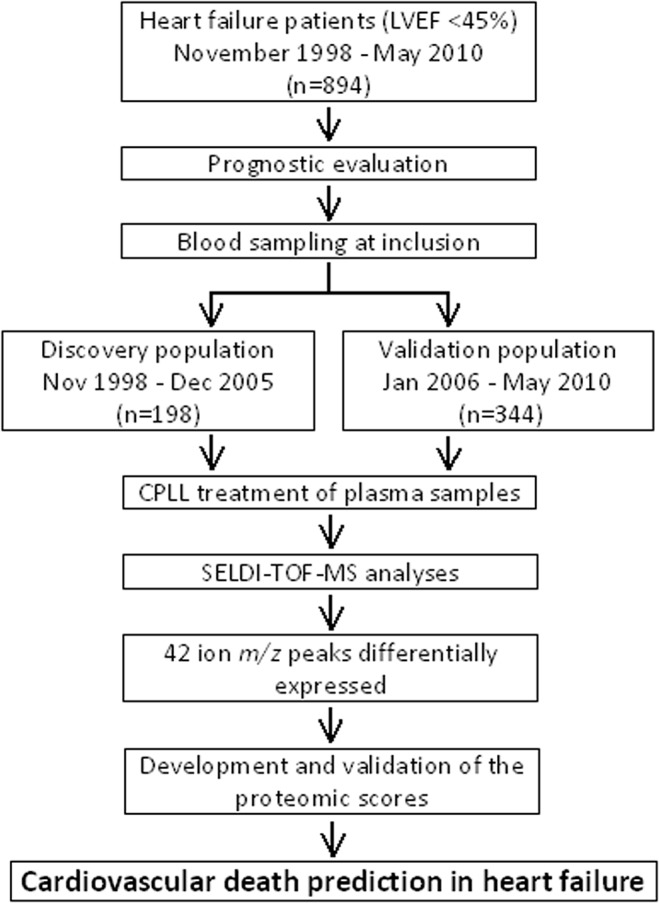
Flow chart of the study.Overview of the study design and analyses performed to build the proteomic scores and to test their validation. A Bonferroni correction was applied on the ion m/z peaks detected by SELDI-TOF analysis. Three different statistical regression methods (SVM, sPLS-DA and LASSO) were used to build the scores with the 42 differentially intense ion m/z peaks. The performance of the proteomic scores was then tested. LVEF: left ventricular ejection fraction, CPLL: Combinatorial peptide ligand library, SELDI-TOF-MS: Surface enhanced laser desorption ionization—time of flight—mass spectrometry.